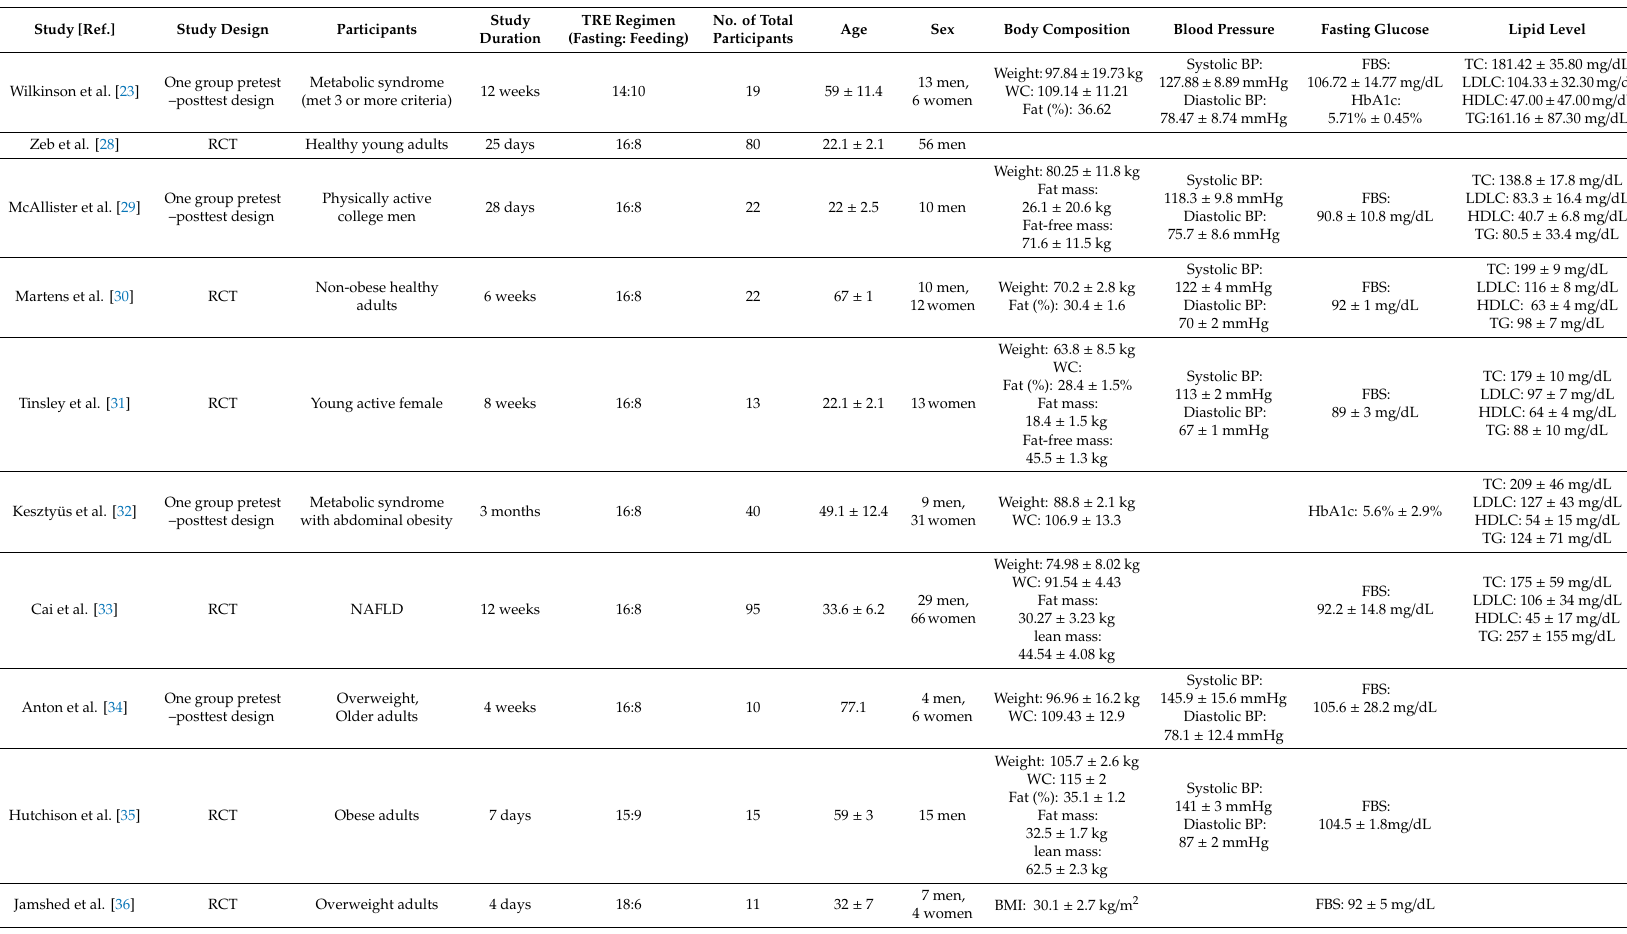
Table 1. Summary of the 19 studies included in the present